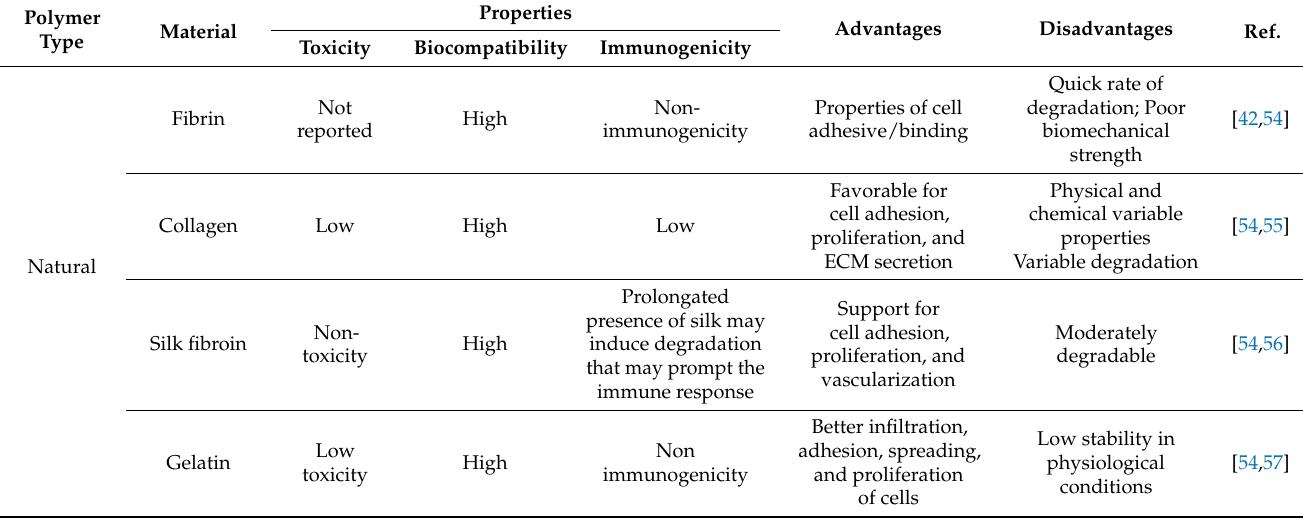
Table 2. Characteristics of some natural, synthetic, and polysaccharide polymers used in biomedical